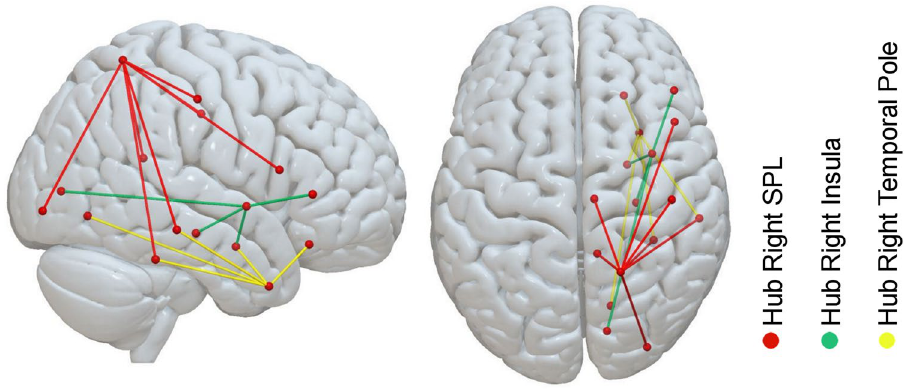
Figure 2. Results of the SVR-CLSM analysis reduced to crucial hubs. To better illustrate findings from Fig. 1, we segmented the (dis)connectome map into subnetworks, depending on whether there were continuous links between nodes or not. We extracted four different components. The figure shows disconnections of the three main hubs with continuously disconnected links of component one. Each color is associated to the disconnected edges of one of the three major hubs with more than three disconnections (the right insula, the right SPL and the right temporal pole). Results are shown from sagittal view (right hemisphere) and superior view. Parcellation into grey matter connectome nodes was done with respect to the Desikan–Killiany atlas 45 . SPL superior parietal